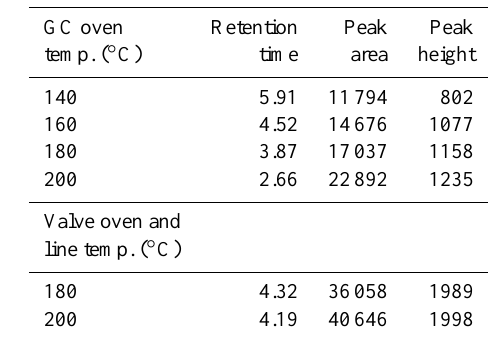
Table 1. GC/MS results from permeation of HgBr 2 with varying GC oven, valve oven, and line temperatures. Each iteration was per- formed at least in duplicate to verify the consistency of results. Peak area and height are for m/z